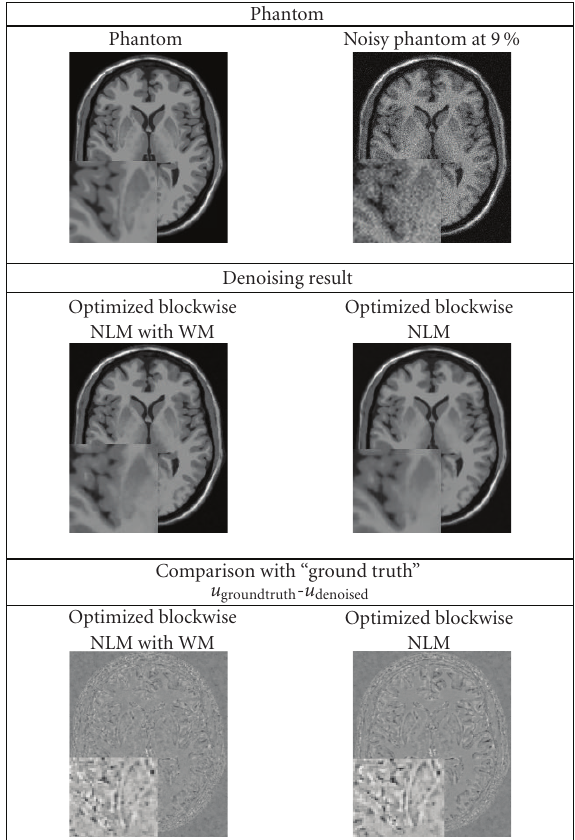
Figure 7: Top. Phantom and phantom noisy with 9%. Middle. The denoising result obtained with the optimized blockwise NLM with WM filter and the optimized blockwise NLM filter. Bottom. The im- age of di ff erence between the phantom and the denoising result (i.e., u groundtruth - u denoised ). The contrast of the zooms have been artificially increased. Visually, less structures have been removed with the opti- mized blockwise NLM with WM filter.